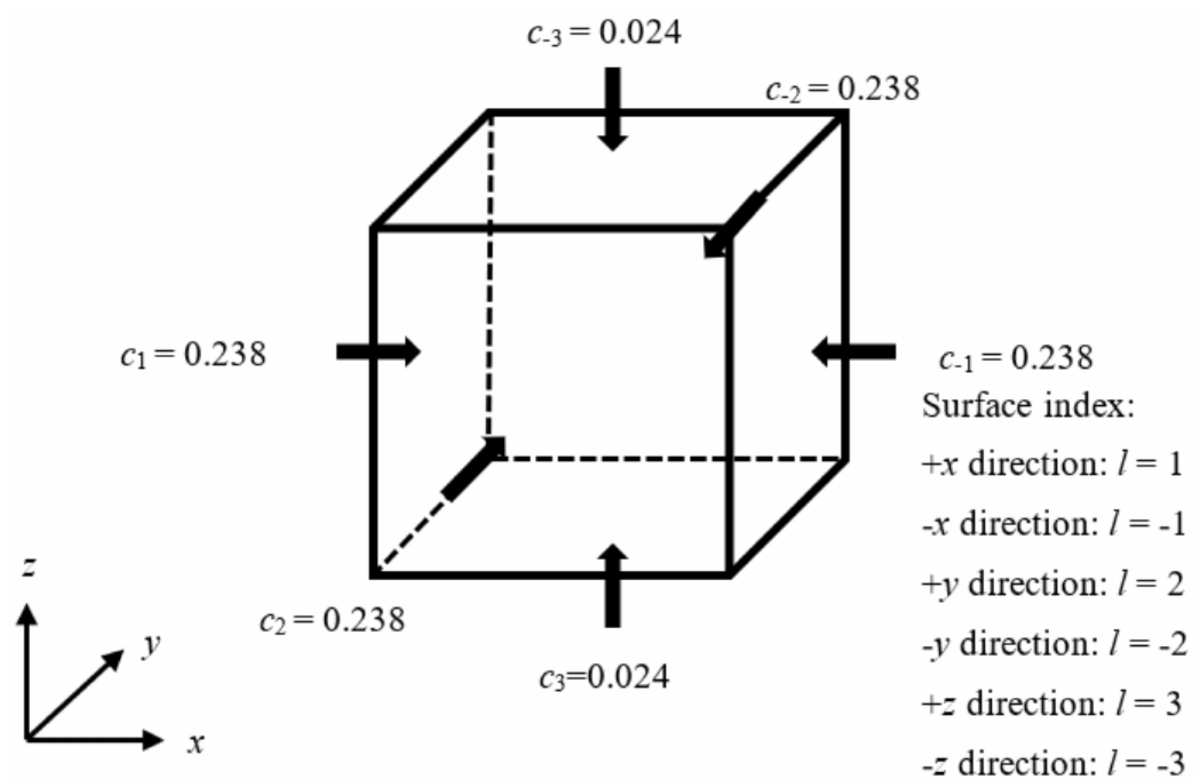
Figure 3. Rectangular prismatic human